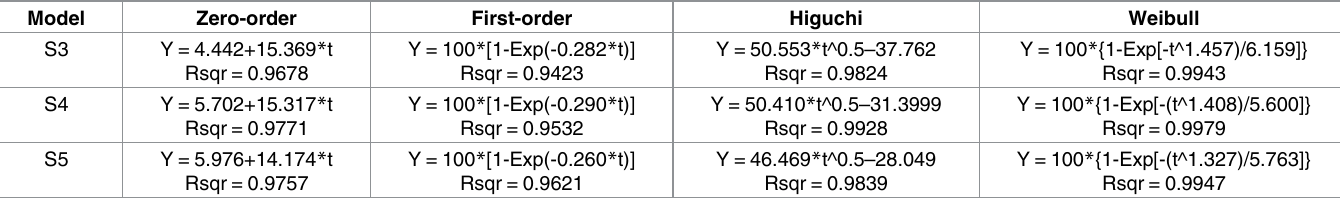
Table 11. Ex vivo permeation kinetics models of geniposide from the optimized